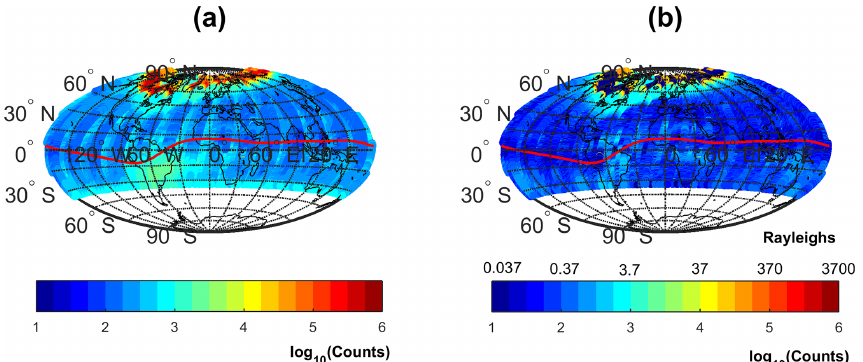
Figure 7. The global count (a) and brightness (b) of the 135.6nm nightside channel from 7 to 11 December 2017. The brightness is without red leak and the effect of dark count. The solid red line indicates the magnetic dip Equator.